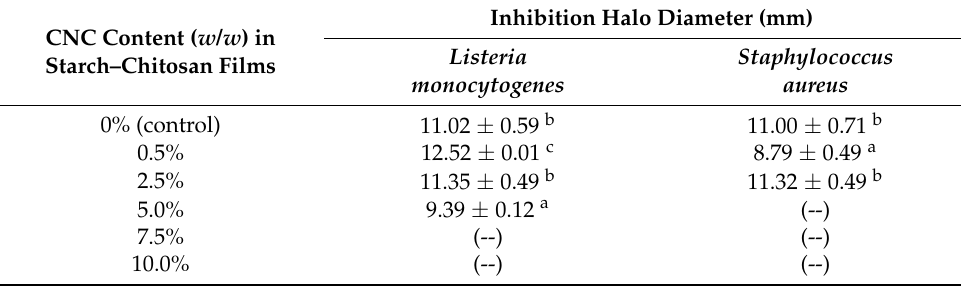
Table 1. Antimicrobial effect of cellulose nanocrystals (CNC) incorporated in corn starch–chitosan biodegradable